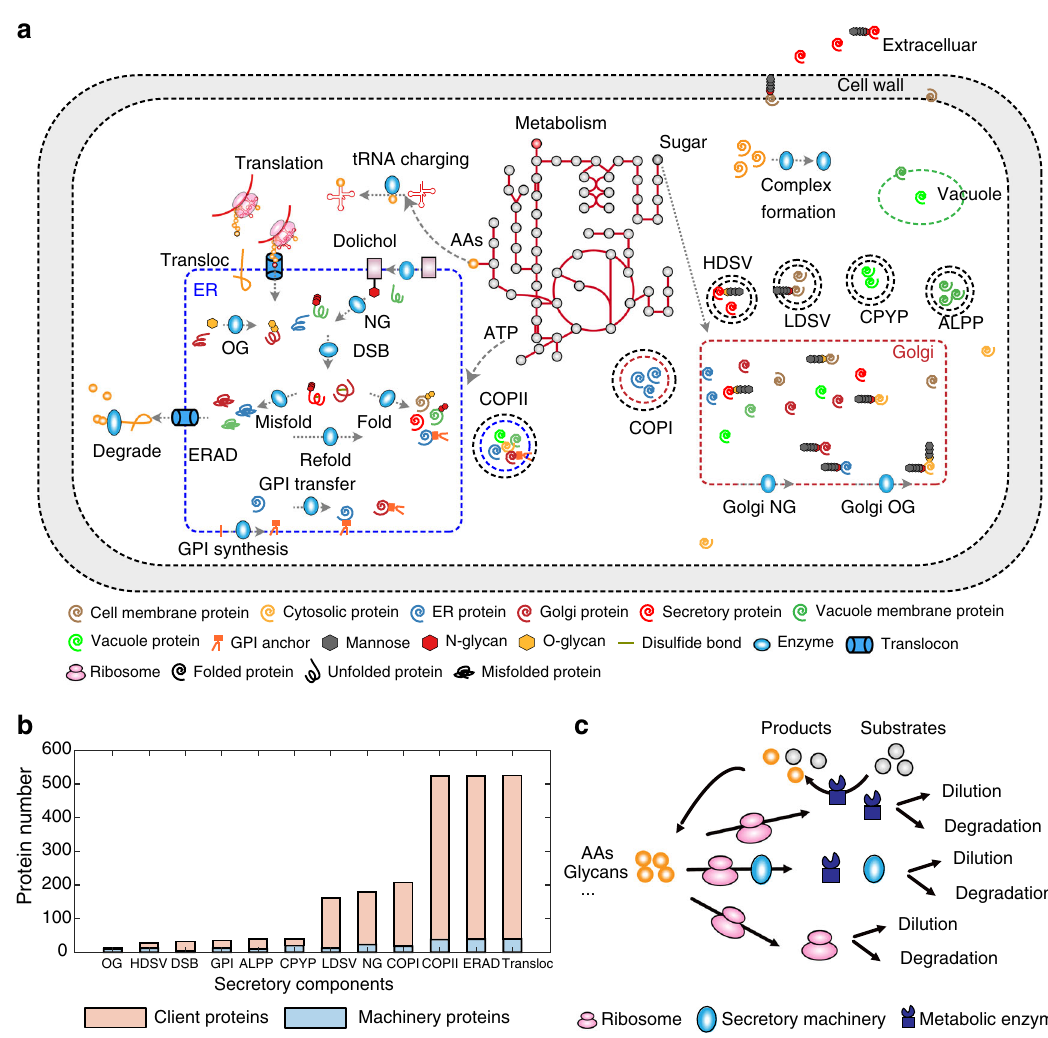
Fig. 1 Overview of components in pcSecYeast. a Simpli fi ed schematic processes involved in the protein secretory pathway. The process includes protein translation, translocation, glycosylate, GPI transfer, ERAD and sorting process. The detailed description of all components and reactions can be found in Supplementary Methods. The protein secretion reactions are added for all proteins in the model that are processed in the secretory pathway based on their PTM pro fi les and amino acid sequences. Transloc translocation, NG N -glycosylation, OG O -glycosylation, DSB disul fi de bond formation, GPI glycosylphosphatidylinositol, ER Endoplasmic reticulum, ERAD ER-associated degradation, LDSV low-density secretory vesicles, HDSV high-density secretory vesicles, ALPP alkaline phosphatase pathway, CPYP carboxypeptidase Y pathway. b Subsystems in the secretory pathway and the protein number in each subsystem. All proteins processed by the secretory pathway are client proteins for Transloc, COPII and ERAD. c Coupling process in the model. The metabolic part produces energy and precursors such as amino acids, glycans for enzyme and ribosome synthesis. Enzymes constrain these metabolic reactions. Ribosomes constrain protein translation. The secretory machinery constrains protein processing in this pathway. All proteins, including ribosomes are diluted due to growth and degraded due to misfolding. Source data are provided as a Source Data fi